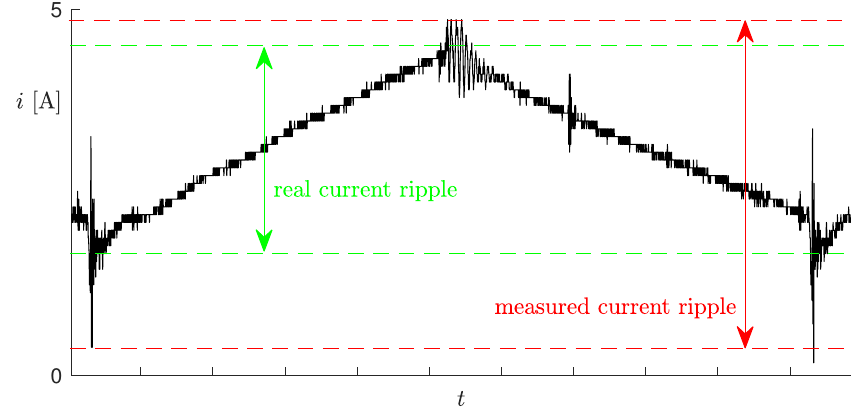
Figure 3. Unfiltered inductor current measurement with the indication of the real current ripple (green) and the wrong current ripple, which could be obtained based on the